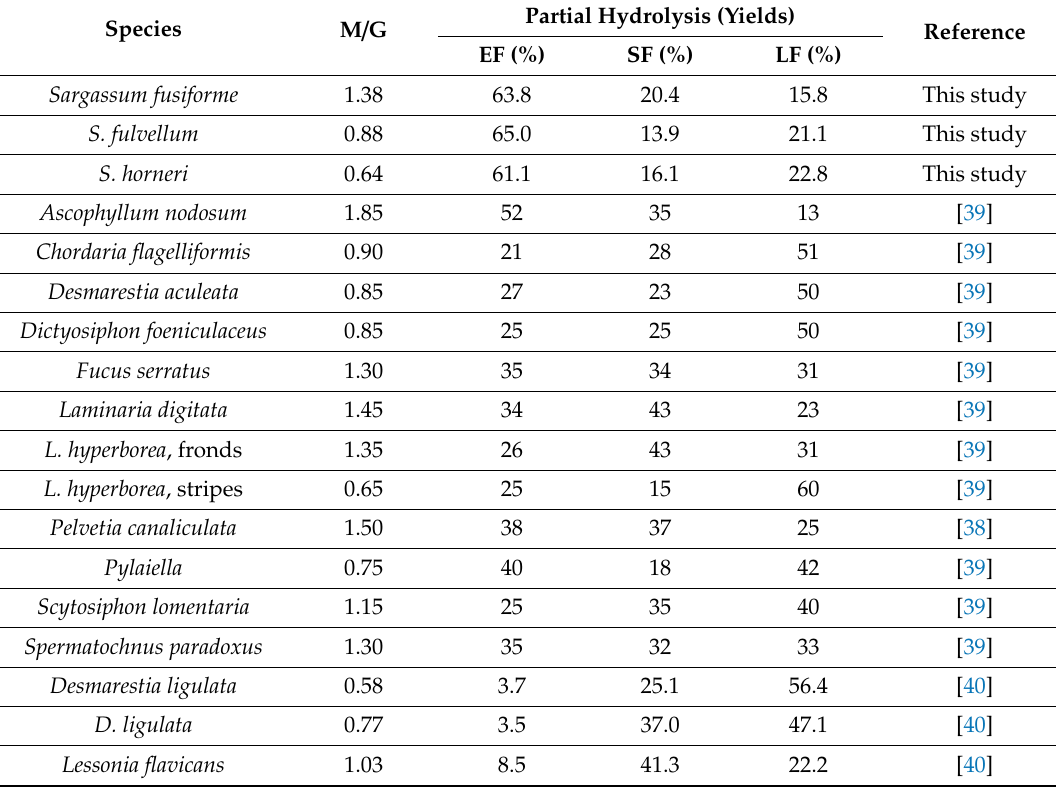
0.58 Lessonia flavicans 1.03